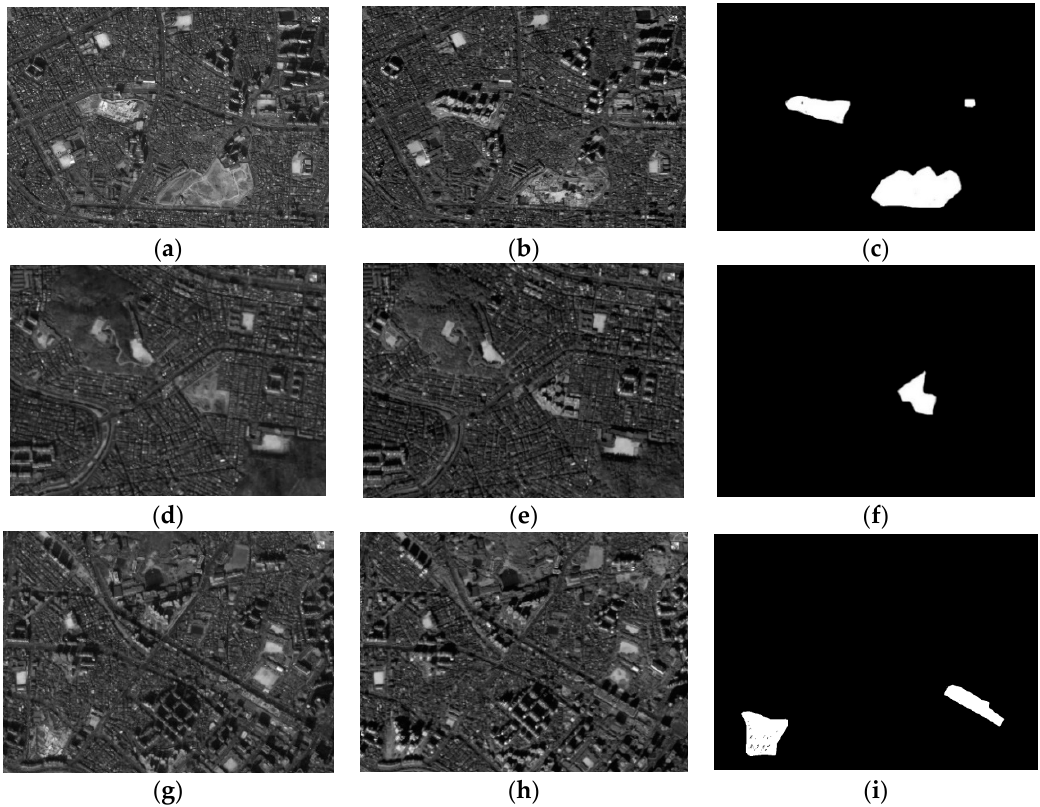
Figure 7. Experiment dataset: ( a ) Input image for Area 1 (March 2014), ( b ), input image for Area 1 (October 2015), ( c ) ground truth for Area 1, ( d ) input image for Area 2 (March 2014), ( e ) input image for Area 2 (October 2015), ( f ) ground truth for Area 2, ( g ) input image for Area 3, (March 2014), ( h ) input image for Area 3 (October 2015), and ( i ) ground truth for Area 3.